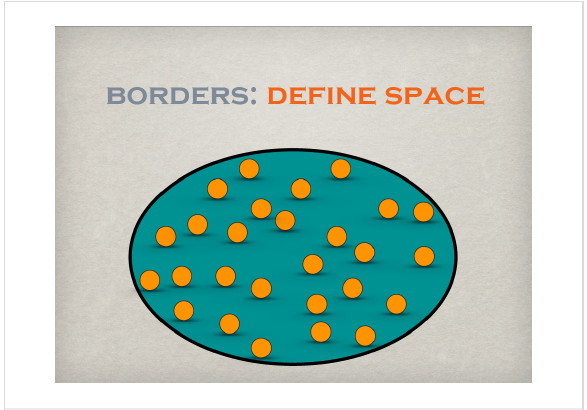
Figure 2: The circle encloses a defined space separated from the sur- rounding.